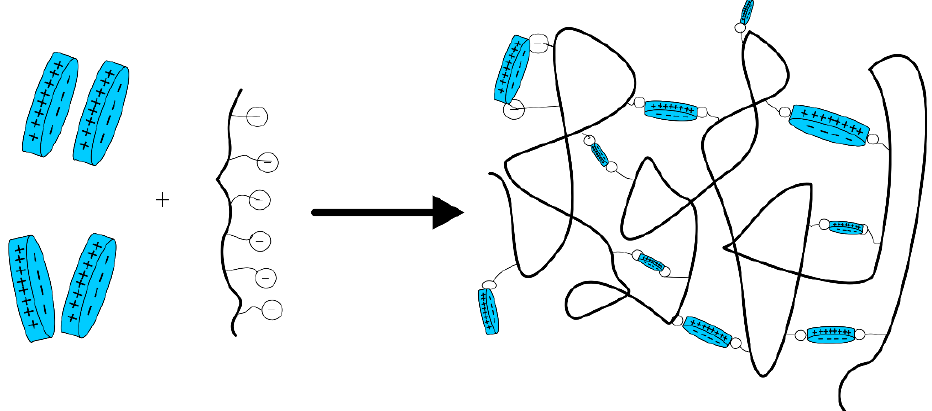
Figure 13. Mechanism of interaction between the anionic polymer and Li-bentonite surface cations [78]. (Adapted from Ref. [78]. 2012, Tongwa, et al”) .